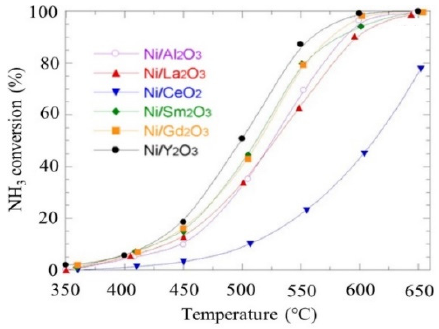
Figure 35. The effects of catalysts support properties on performance of ammonia decomposition at temperatures from 250 to 800 °C ( a ) ammonia conversion at different temperatures ( b ) different support catalysts with the highest conversion rate for the Ni/MgAl 2 O 4 - LDH catalyst ( c ) time course of different support catalysts and ( d ) time course of ammonia conversion at 550 to 600 °C [132].